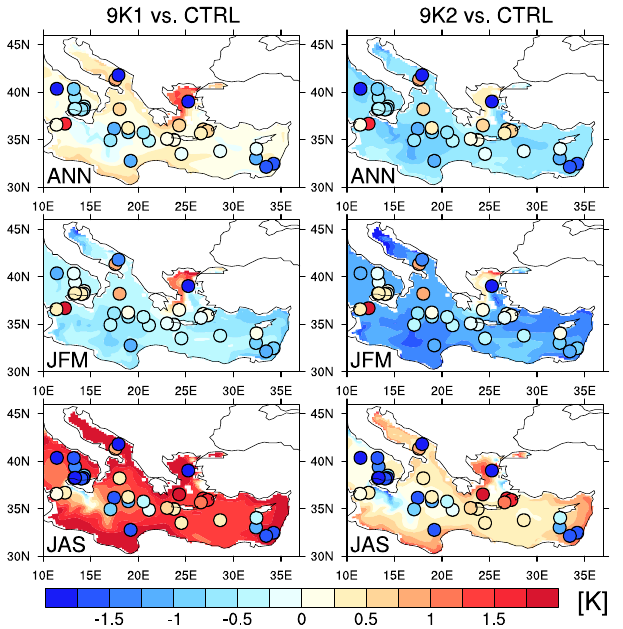
Fig. 19. Annual, winter (JFM) and summer (JAS) SST anomalies, reconstructed from proxy data (dots, Kucera et al. (2011)) vs. mod- elled one (background colour) for 9K1 vs. CTRL (left) and 9K2 vs. CTRL (right). 1st row displays annual SST anomalies, 2nd row displays winter SST anomalies, 3rd row displays summer SST anomalies.